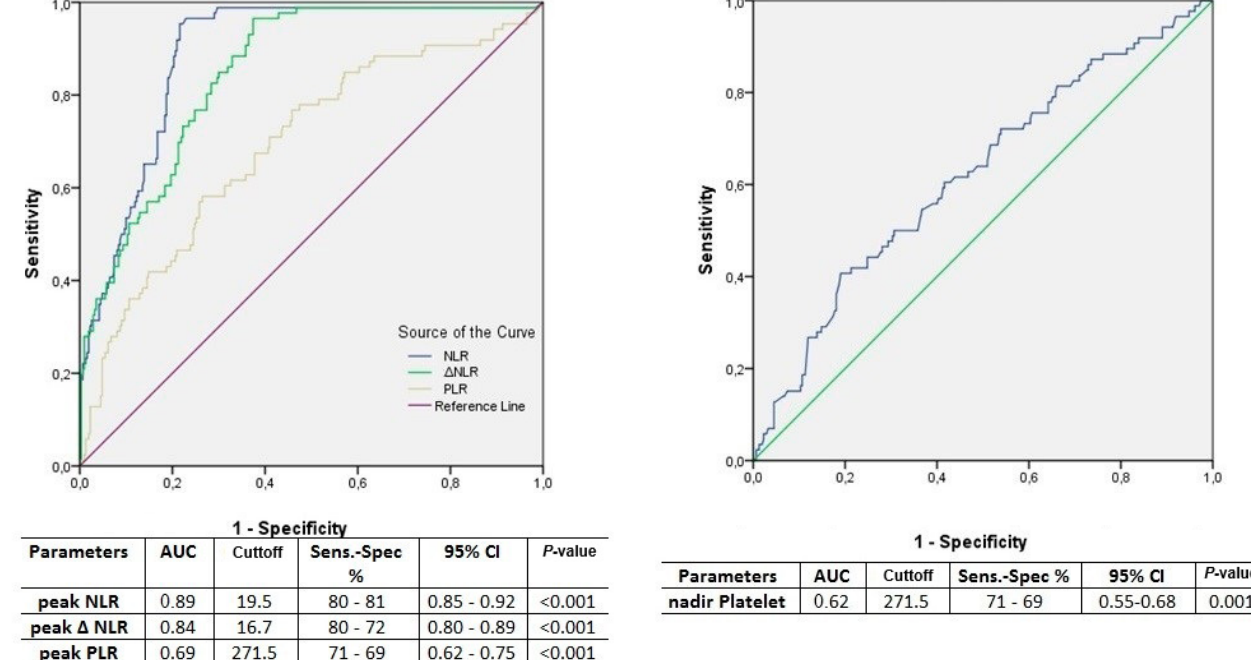
Fig. 3 - Receiver operating curve analysis of the peak neutrophil-lymphocyte ratio (NLR), peak delta(Δ)-NLR, and nadir platelet-lymphocyte ratio (PLR) values for the first four postoperative days regarding the occurrence of postoperative acute kidney injury during hospital stay. AUC=area under the curve; CI=confidence interval; Sens.=sensitivity; Spec.=specificity